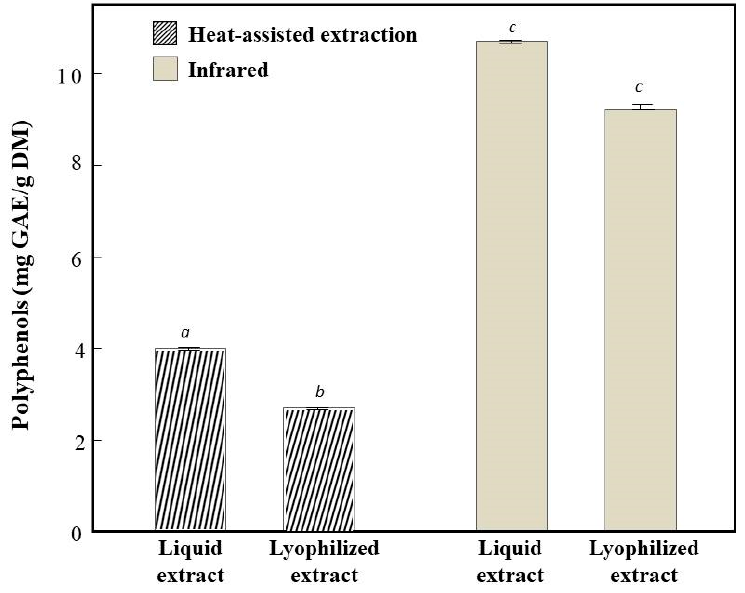
Figure 1. Polyphenol content of heat-assisted extraction and infrared apricot pomace extracts (liquid and lyophilized). Different superscript letters indicate significant statistical difference ( p < 0.05).